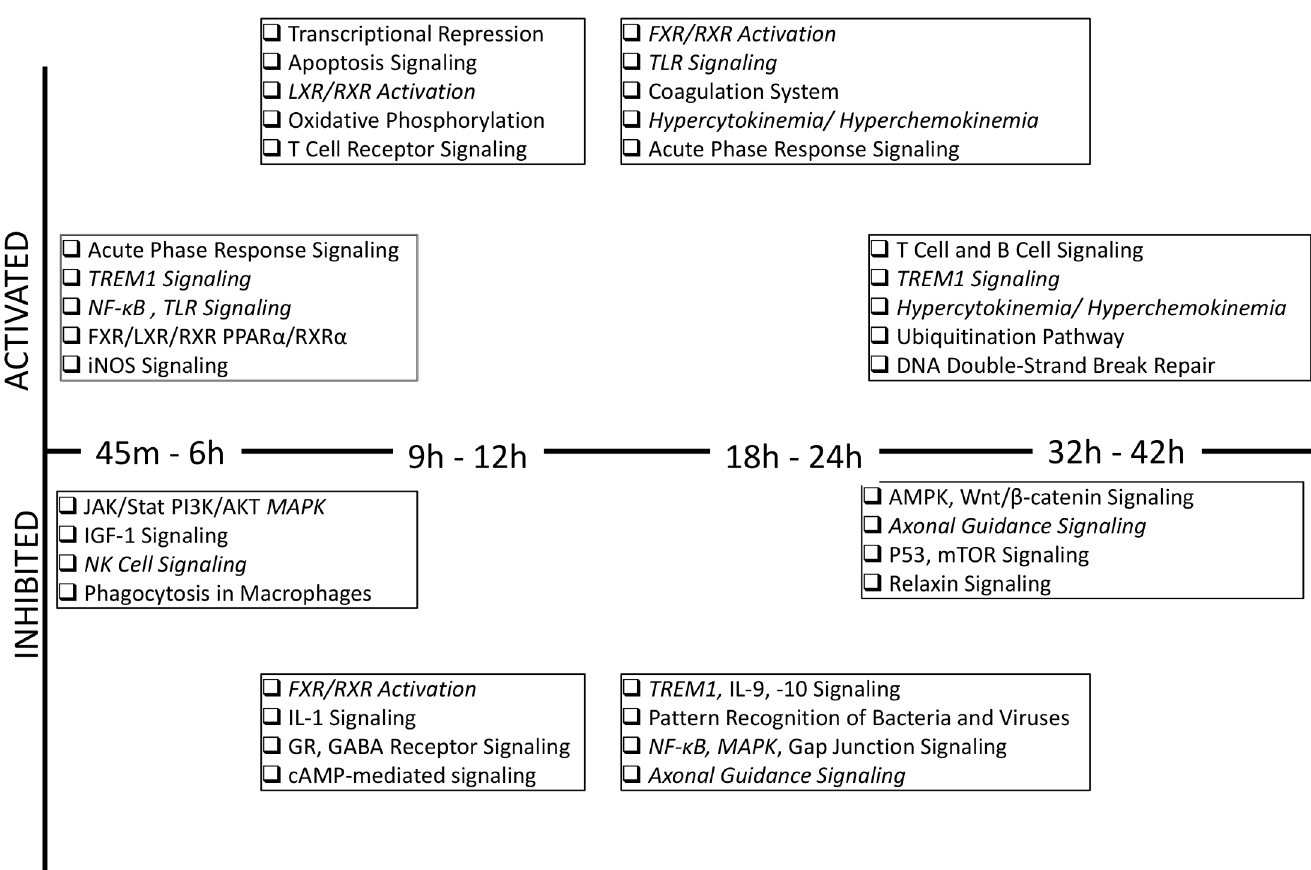
Fig 2. Potentially activated and inhibited GoI- Time enriched pathways across the time course. The canonical pathways enriched by up- or down- regulated genes differentially regulated at 45 m-6 h, 9 h-12 h, 18 h-24 h and 32 h-42 h post-exposure are listed. The pathways constituted by the up-regulated genes are listed in the “ Activated ” section; the pathways constituted by the down-regulated genes are listed in the “ Inhibited ” section. The functions documented more than once are in